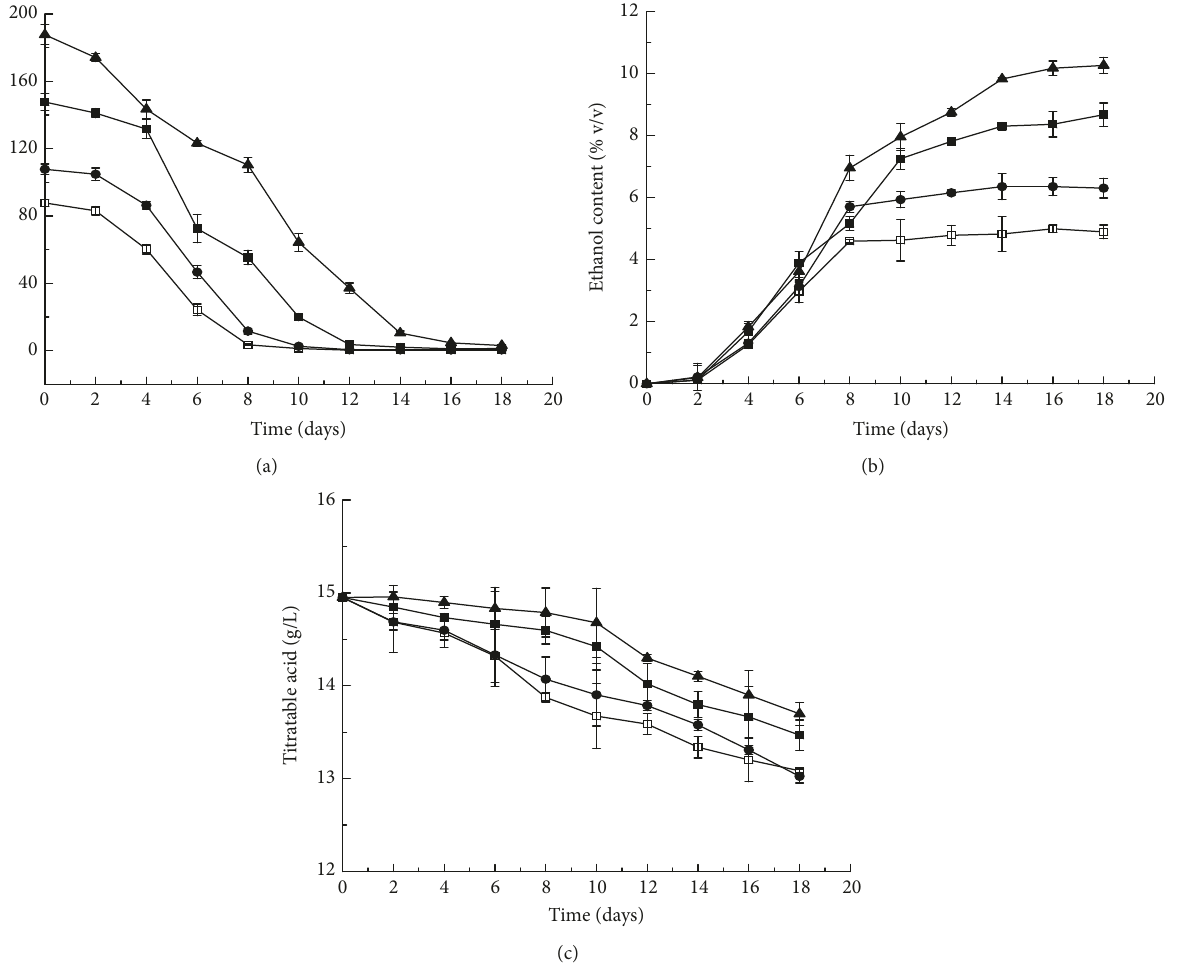
Figure 2: Changes of chemical parameters including total sugar content (a), ethanol content (b), and titrable acidity (c) of “Shuangyou” wines added with 20 ( e ), 60 ( ◼ ), and 100 ( 󳵳 ) g/L sucrose and controls ( ◻ ) during fermentation.